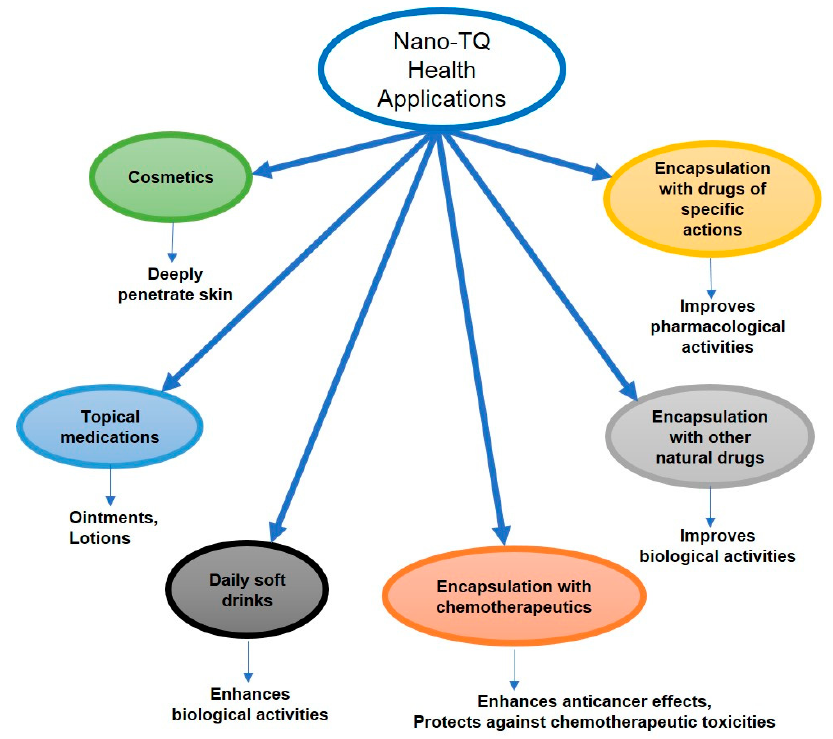
Figure 6. Nano-TQ and its uses in health and nutrition.